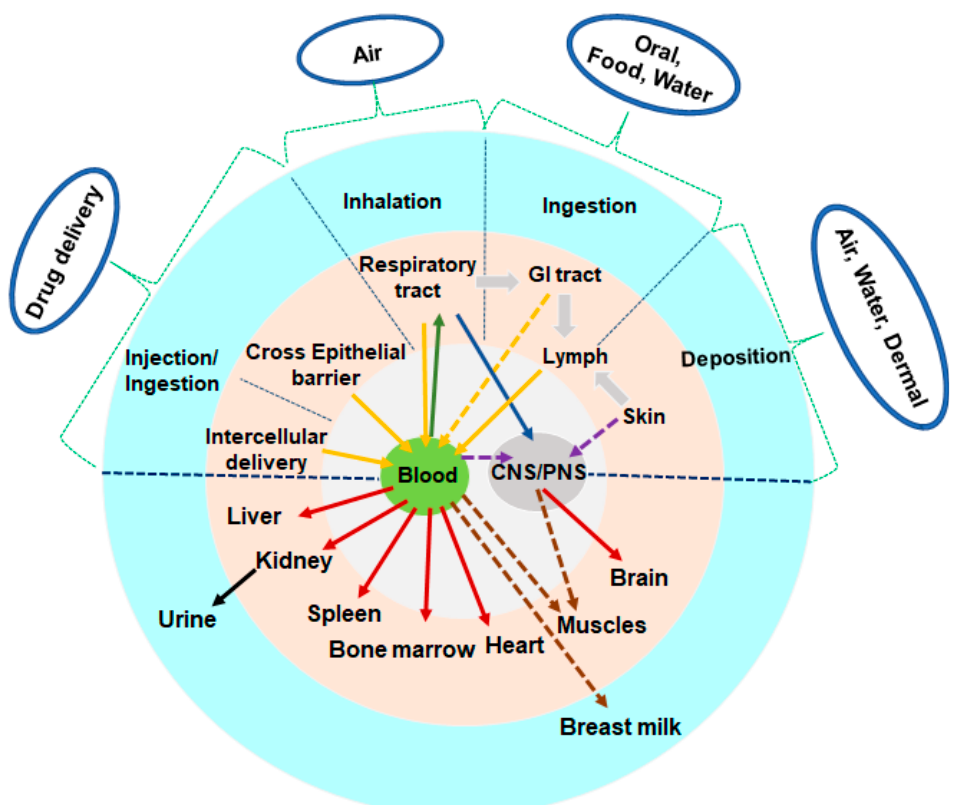
Figure 1. Nanoparticle and its bio interaction. The physicochemical characteristics of the surface and core of nano-sized particles will mostly determine the potential harmful consequences. Though several absorption and translocation pathways have been demonstrated, others remain hypothetical and must be studied.